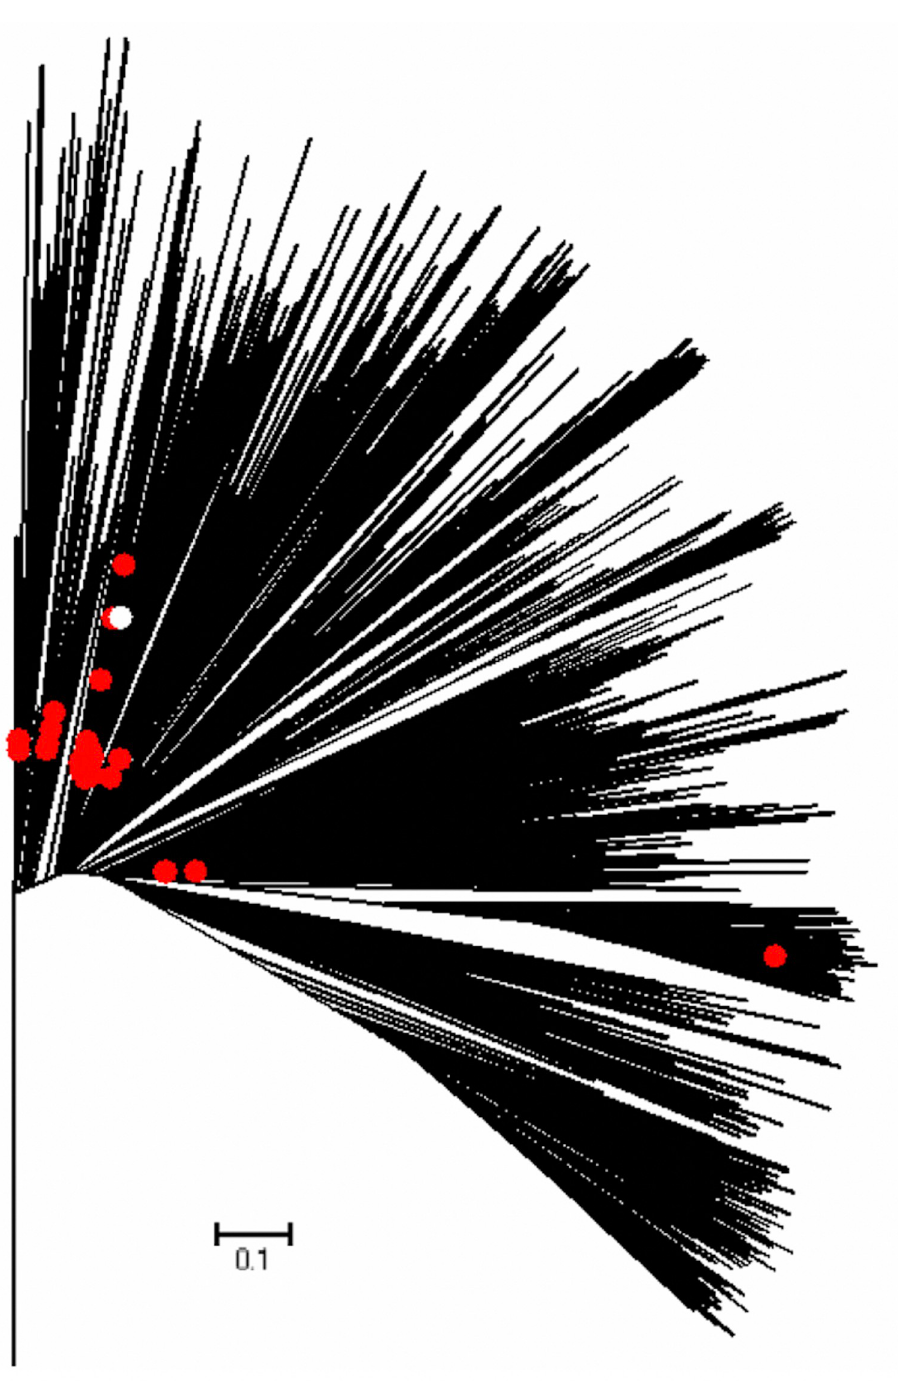
Fig 9. Global Maximum Likelihood (ML) tree for SARS-CoV-2 genomic data analyzed in the paper. The leaves of the tree are Colombian sequences of SARS-CoV-2 sampled between February 27, 2020, and April 5, 2020 (highlighted in red) and background sequences sampled from around the globe for genomic context. Colombian sequences are distributed among different lineages, indicating multiple virus introductions. The largest estimated intra-Colombian cluster (i.e., a monophyletic clade consisting solely of Colombian sequences) was analyzed using an exponential growth coalescent model to estimate the intra-country basic reproduction number.